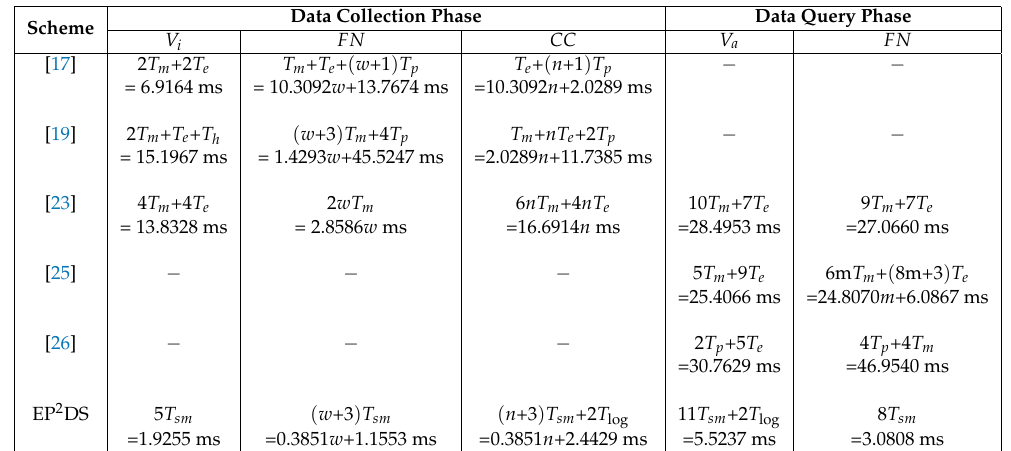
Table 4. Comparison of computation